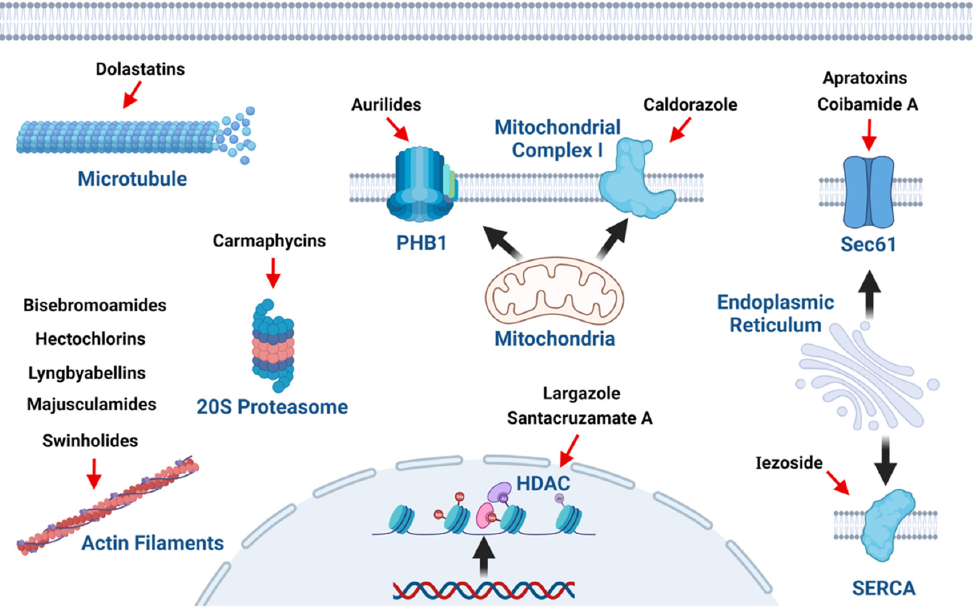
Figure 24. Suggested molecular targets of metabolite families isolated from marine cyanobacteria related to anticancer effects (Created by Robles-Bañuelos et al. with BioRender.com). PHB1, prohibitin 1; HDAC, histone deacetylase; and SERCA, sarco/endoplasmic reticulum Ca 2+ -ATPase. In this review are also included some underreported families of metabolites, such as